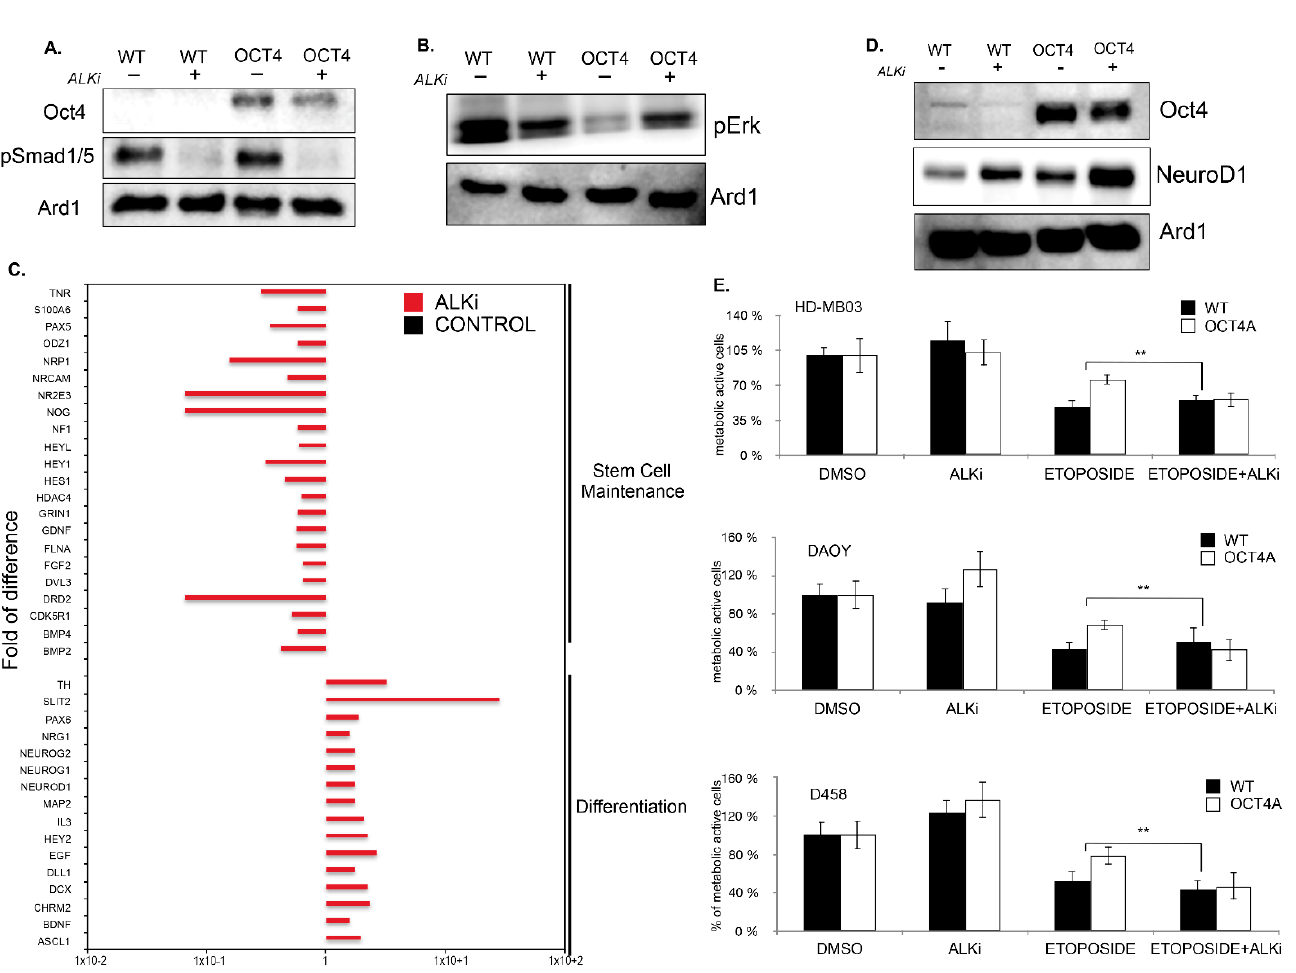
Figure 6. The ALK2/3 inhibitor, LDN 198836, promotes MB cell differentiation and cytotoxicity to chemotherapy. ( A ) Immunoblot analysis showing the level pSmad1/5 in parental HD-MB03 (WT) and OCT4-overexpressing (OCT4) cells treated or untreated with ALK2/3 inhibitor (LDN 198836). ( B ) Immunoblot analysis showing the p-ERK levels in parental HD-MB03 (WT) and OCT4-overexpressing (OCT4) cells treated or untreated with ALK2/3 inhibitor LDN 198836. ( C ) RT2 profiler PCR arrays performed in HD-MB03 cells showing the differentially regulated genes upon treatment with ALK2/3 inhibitor (LDN 198836) compared to untreated parental (WT) cells and normalized to the expression of housekeeping gene ACTB. ** p < 0.01. ( D ) Immunoblot analysis showing the level of